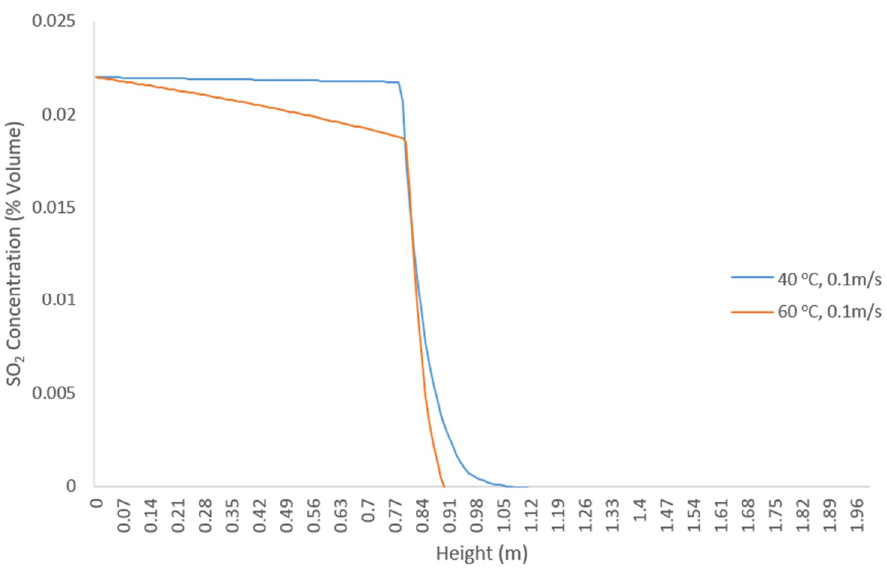
Figure 8. Comparison of SO 2 concentration across the bed between 40 °C and 60 °C at a velocity of 0.1 m/s.